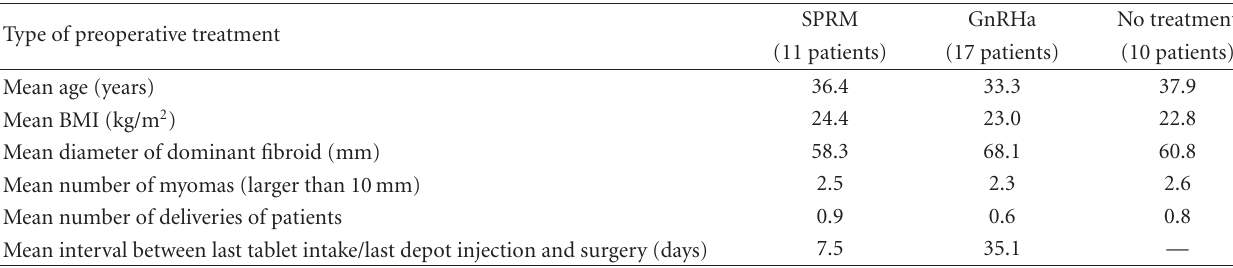
Table 1: Baseline parameters of the groups of the study.